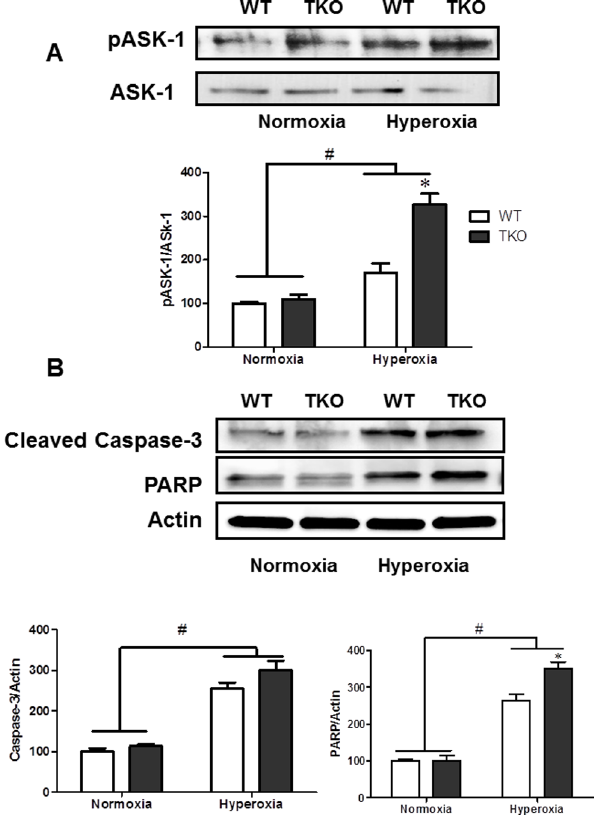
Figure 7. Deletion of TXNIP augments hyperoxia-induced ASK- 1 activation and apoptotic markers. Wild type (WT) and TXNIP knockout (TKO) mice were subjected to 5 days hyperoxia (p7–12). Retinas were collected for protein ASK-1 ( A ) and apoptotic markers (Cleaved Caspase-3 and PARP) ( B ). A 2 6 2 analysis showed a significant interaction between gene (TKO) and oxygen levels (Hyperoxia) in activation of ASK-1. In parallen, Hyperoxia caused significant increase in cleaved caspase-3 and PARP expression compared to normoxia in WT and TKO. Reduced Trx levels were associated with a significant increase in activation of the apoptotic ASK-1, PARP and caspase-3 pathway. ( # P , 0.05 Hyperoxia vs Normoxia, *P , 0.05, TKO vs WT, n=4–6).